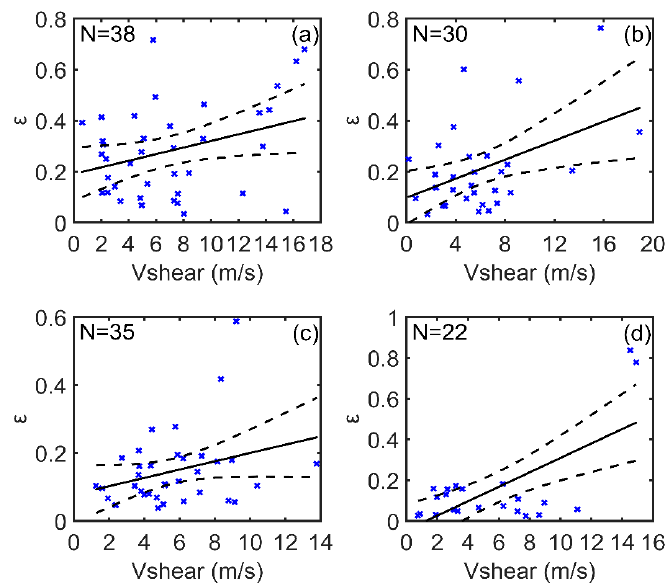
Figure 8. Asymmetry parameter ( ε ) versus the environmental vertical wind shear magnitude ( V shear ) for ( a ) a tropical storm, ( b ) typhoon, ( c ) severe typhoon, and ( d ) super typhoon, as shown in Figure 3. The number of storms for each group is marked. The black solid and dashed lines represent the linear regressions and 95% confidence intervals for the fits, respectively. Table 3. Linear regression coefficients for the asymmetry parameter ( 𝜀 ) versus the typhoon translation speed ( 𝑉 (cid:3046)(cid:3047)(cid:3042)(cid:3045)(cid:3040) ) [ 𝜀 = 𝑎 + 𝑏𝑉 (cid:3046)(cid:3047)(cid:3042)(cid:3045)(cid:3040) ] (Figure 7), and the asymmetry parameter ( ε ) versus the environmental vertical wind shear magnitude ( 𝑉 (cid:3046)(cid:3035)(cid:3032)(cid:3028)(cid:3045) ) [ 𝜀 = 𝑐 + 𝑑𝑉 (cid:3046)(cid:3035)(cid:3032)(cid:3028)(cid:3045) ] (Figure 8) for different intensity groups.